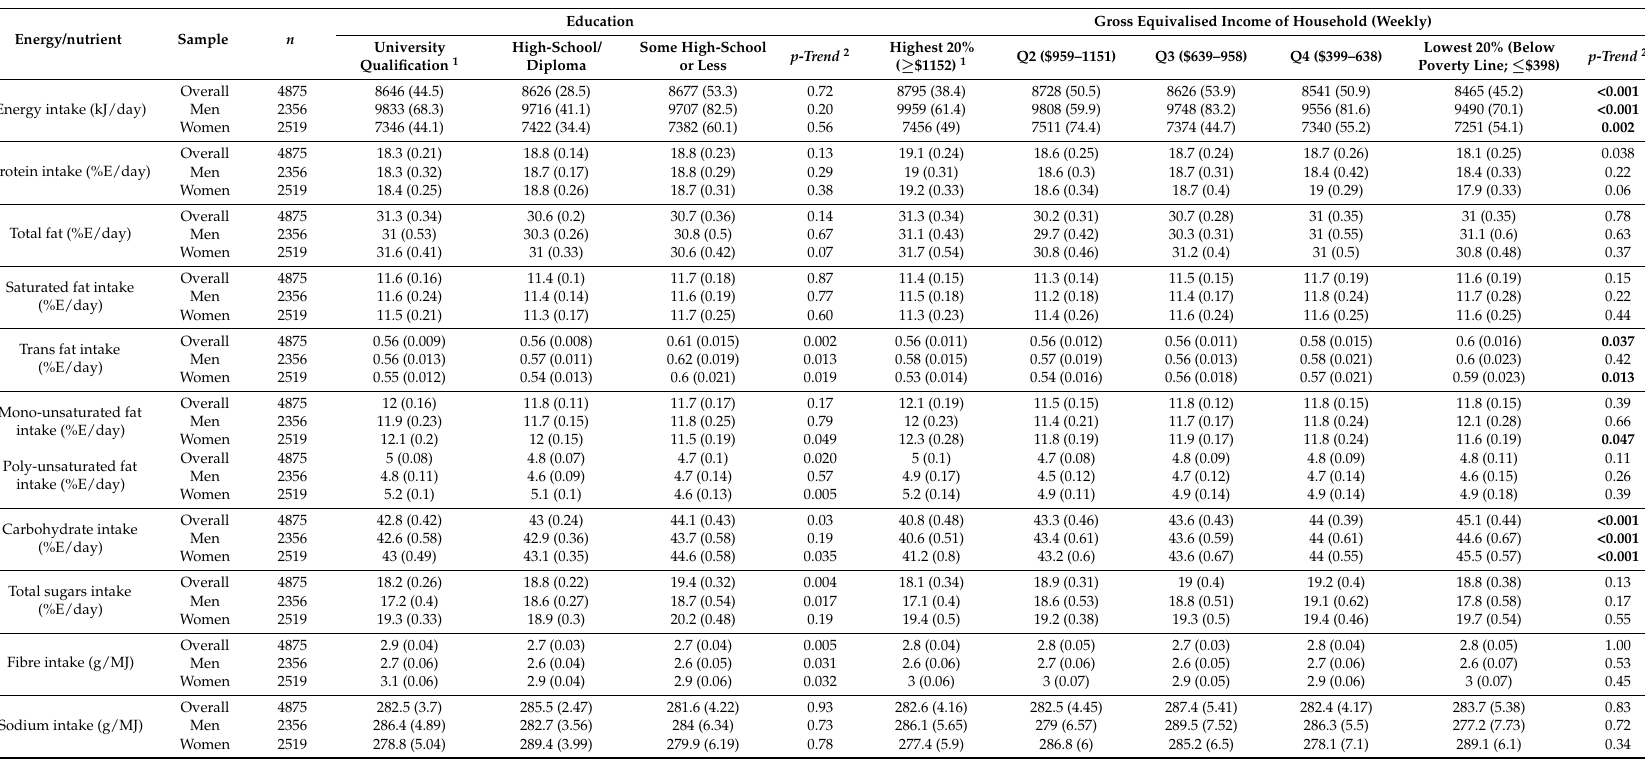
Table 4. Total energy and nutrient intakes by education and income in men ( n = 2356) and women ( n = 2519) from the 2011-13 Australian National Nutrition and Physical Activity